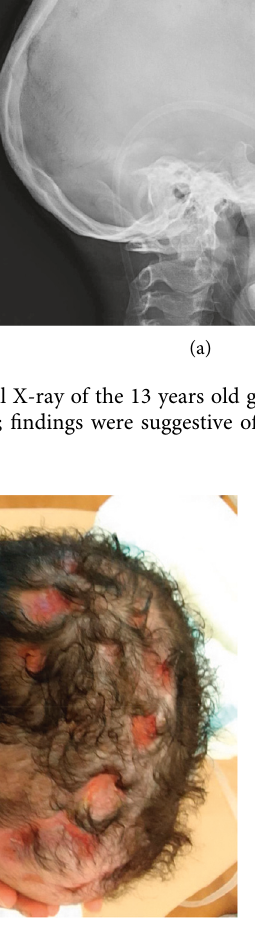
Figure 8: Healing scalp lesions. The picture was taken just recently while being treated at